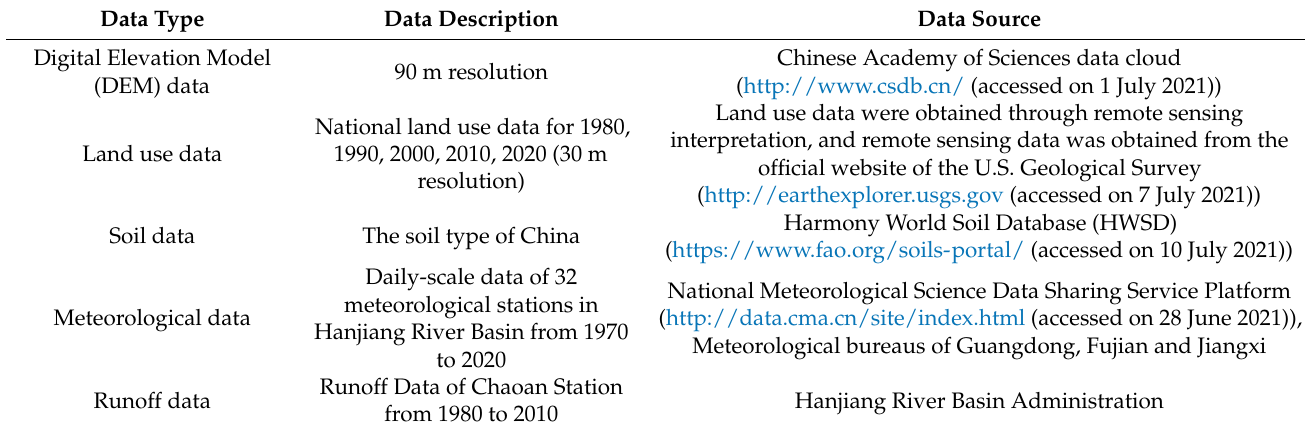
Table 1. Research data and